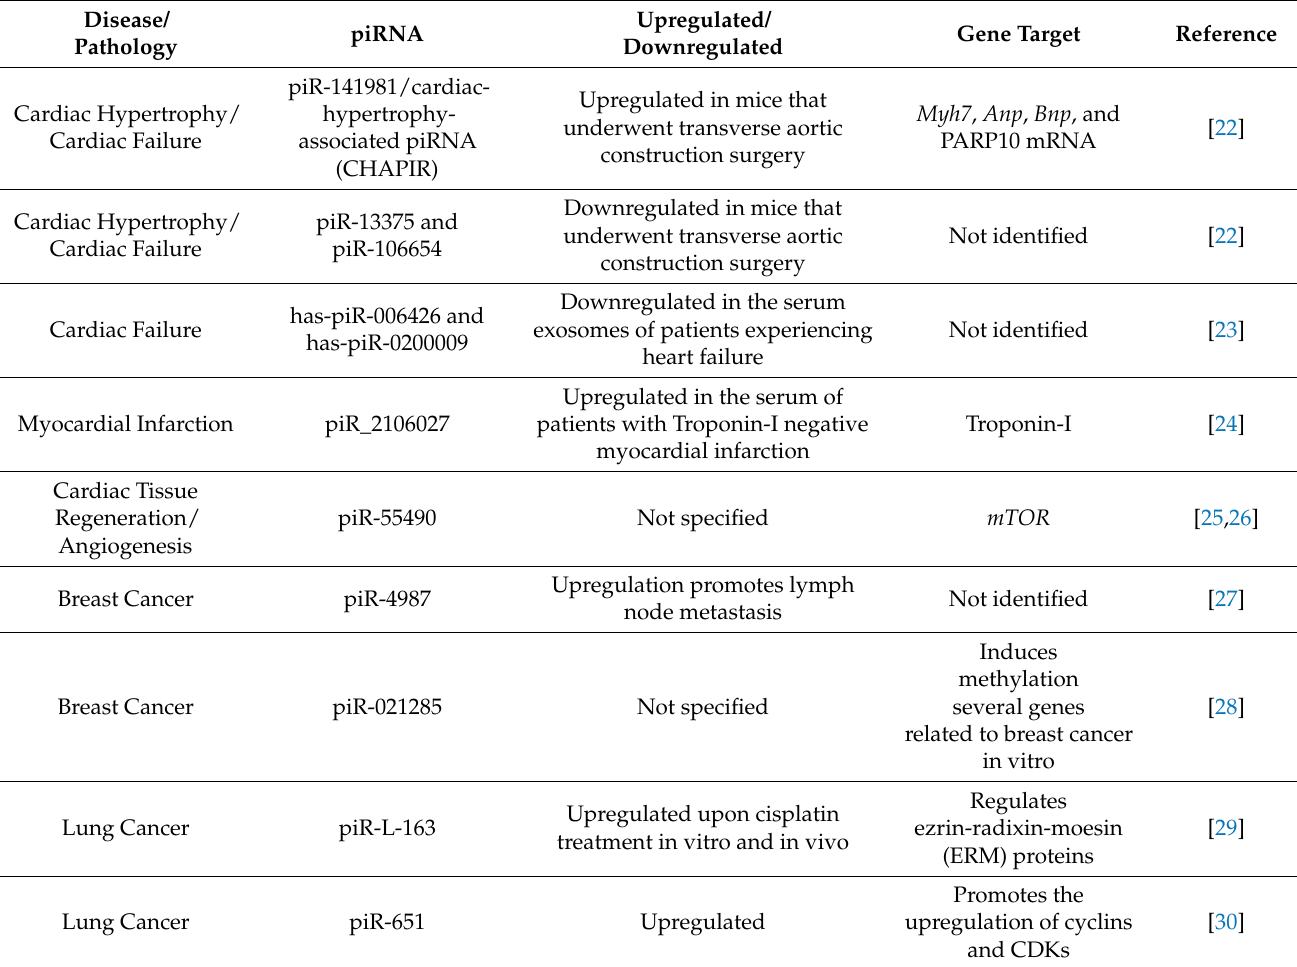
Table 1. piRNAs associated with various